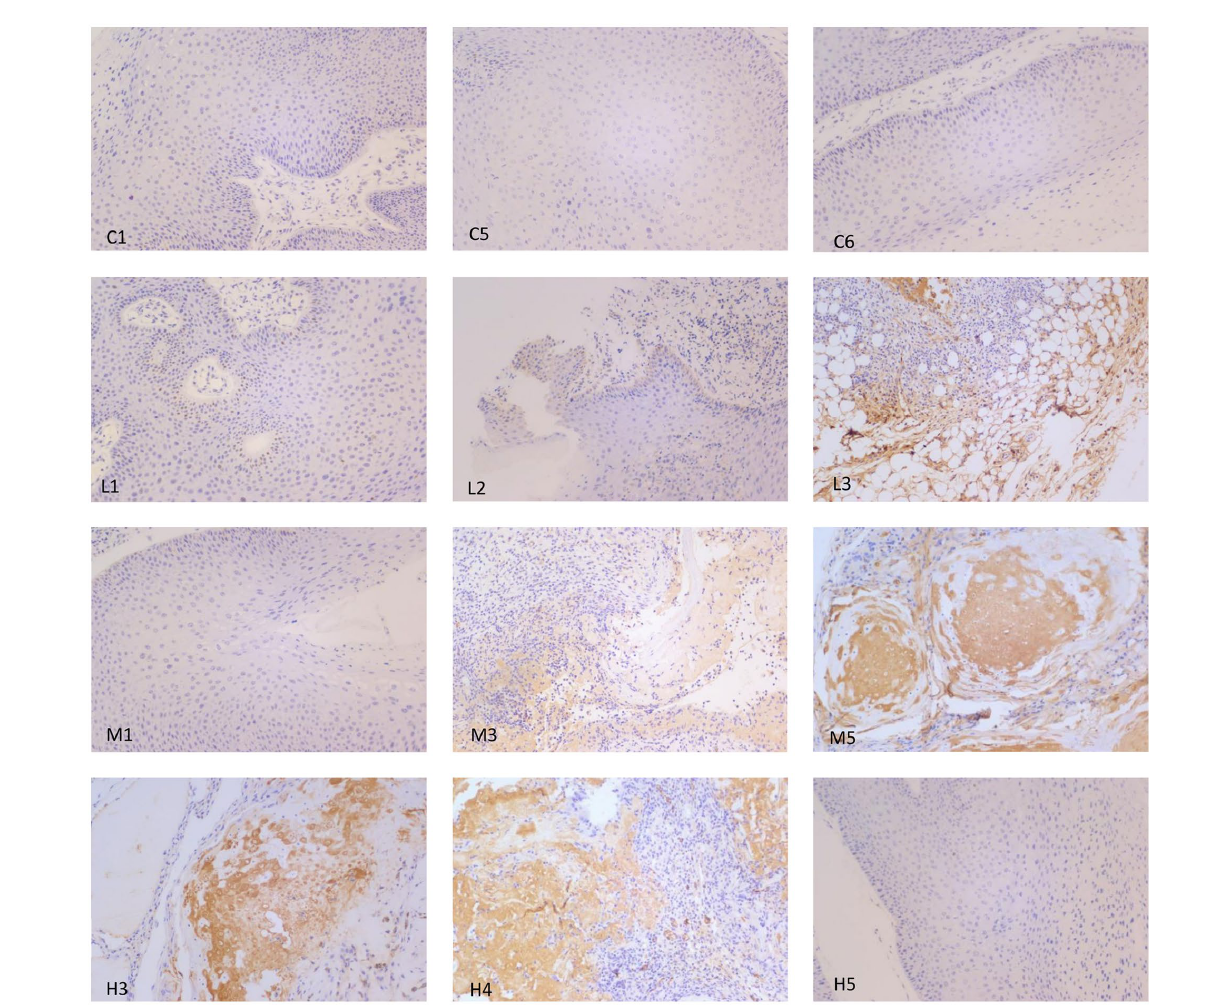
FIGURE 5 Representative images of p53 immunohistochemistry analysis in the different groups of nude mice. Magnification, × 200. In the control group, tissue samples from mice nos. 1, 3 and 5 (C1, C5 and C6, respectively) were selected for p53 staining, and the results showed that there was no visible expression of p53 in the three samples. In the low-dose group, tissue samples from mice nos. 1, 2 and 3 (L1, L2 and L3, respectively) were used for p53 staining. Only a small number of p53-positive cells were expressed per section. In the medium-dose group, tissue samples from mice nos. 1, 3 and 5 were used for p53 staining. Only a small number of p53-positive cells were observed in M1. M3 and M5 showed strong positive expression of p53. In the high-dose group, tissue samples for mice nos. 3, 4 and 5 were selected for p53 staining. A section of H3 exhibited a small amount of